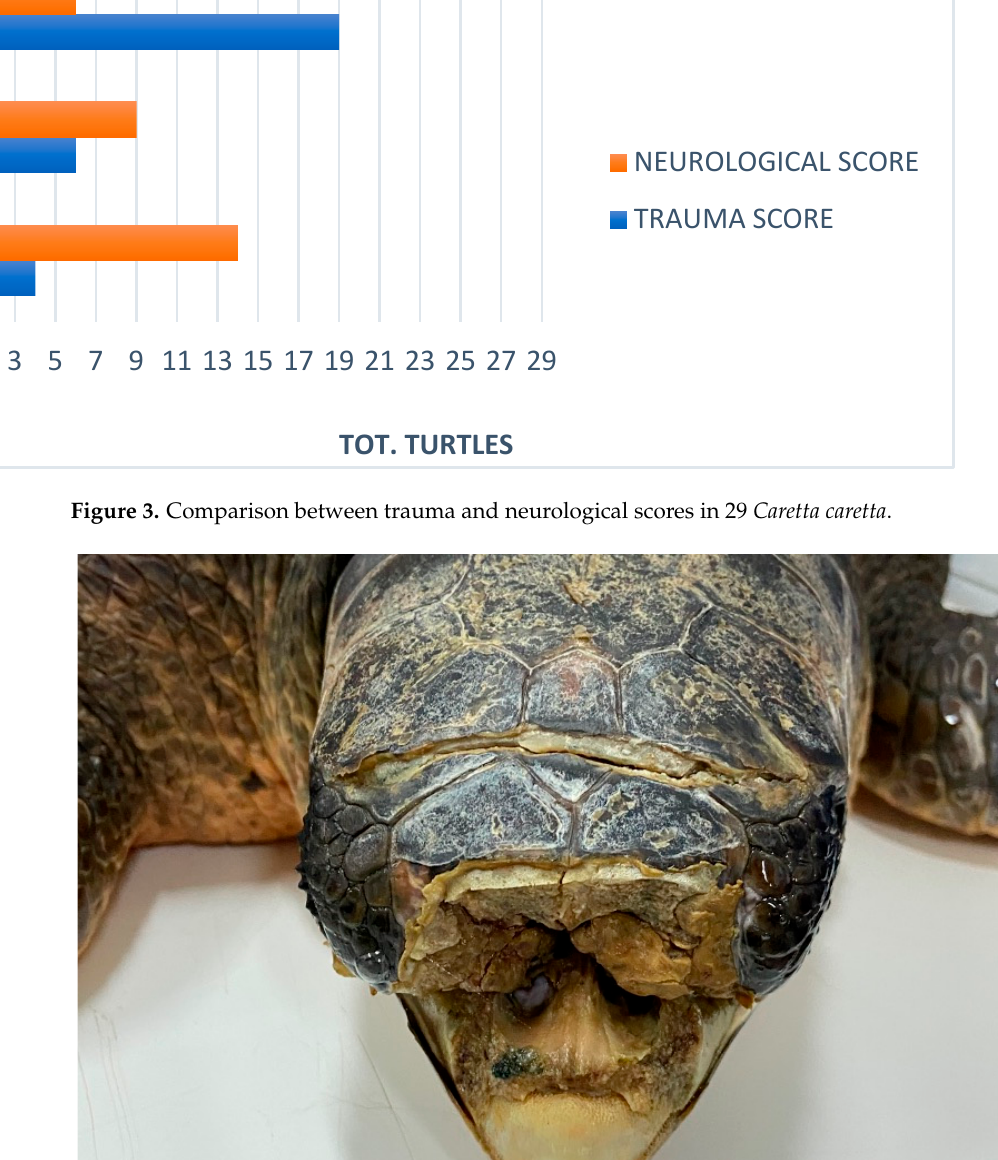
Figure 4. Caretta caretta with fracture of the frontal and nasal bones and massive loss of bone tissue with impaired sense organs and exposure of the nasal cavities.